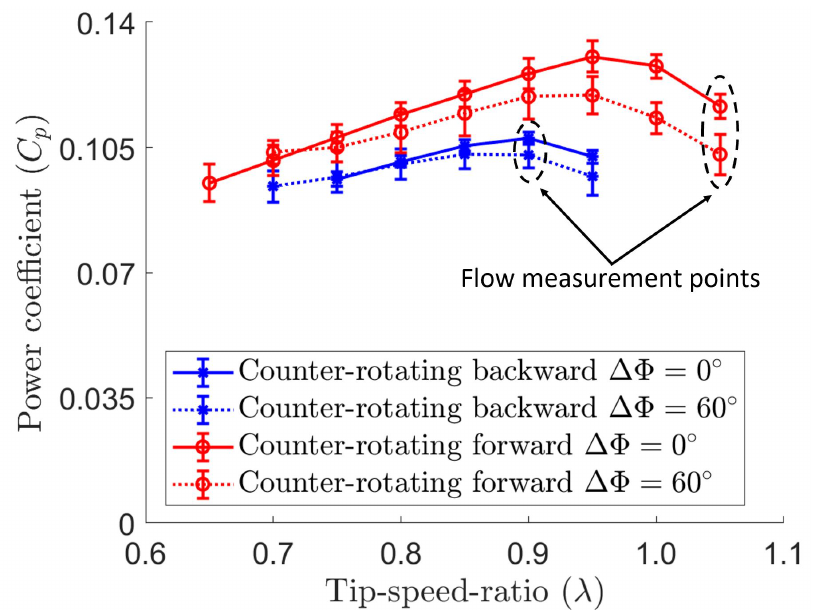
Figure 5. The power curves of counter-rotating configurations, which was adapted from [10], with the flow measurement points